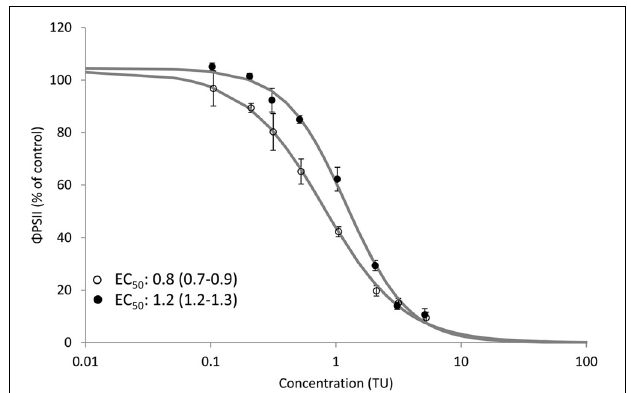
FIGURE 3 | Dose response relationship for the effect of an equitoxic mixture of Irgarol and diuron on the effective PSII efficiency ( (cid:2) PSII) (% of control) of D. tertiolecta after 4.5h of exposure under two seasonal light regimes. EC 50 values and corresponding 95% confidence intervals (TU) are presented for both dose response relationships. Open (SPRING) and closed (AUTUMN) circles represent average (cid:2) PSII and the solid line is the log-logistic model. Error bars represent standard deviation. Concentration is expressed as Toxic Unit (TU). N = 6 for treatments; N = 11 for